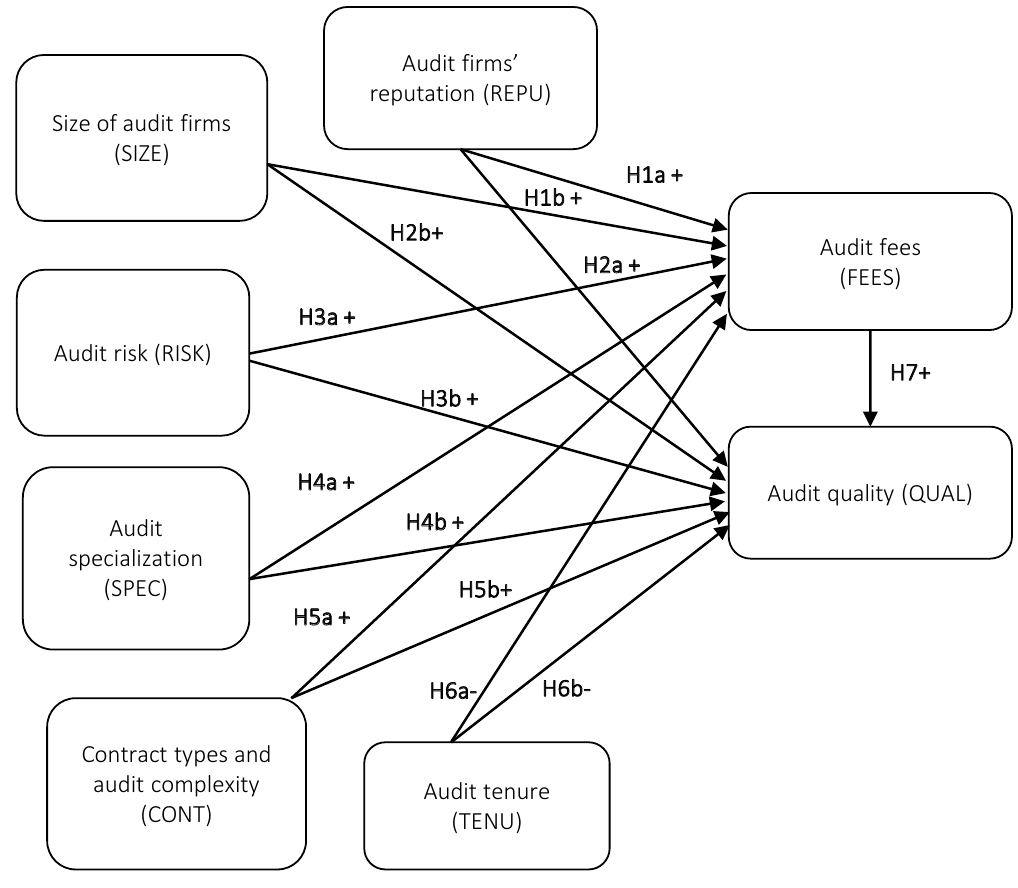
Figure 1. Conceptual research